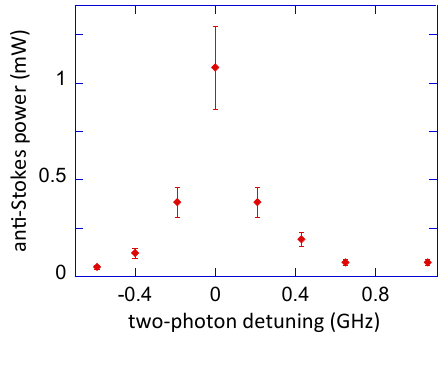
Figure 5. The power of the 807 nm anti-Stokes beam as a function of two-photon Raman − ν ) − ν detuning, ( ν , at a D gas pressure of 0.01 atm. At these low pressures, pump Stokes ab 2 Doppler broadening is the dominant contribution to the linewidth. The two-photon detuning is varied by locking either the pump or the Stokes beam to a different cavity mode. As a result, the data points are spaced in frequency by the free spectral range of the cavity, which is 200